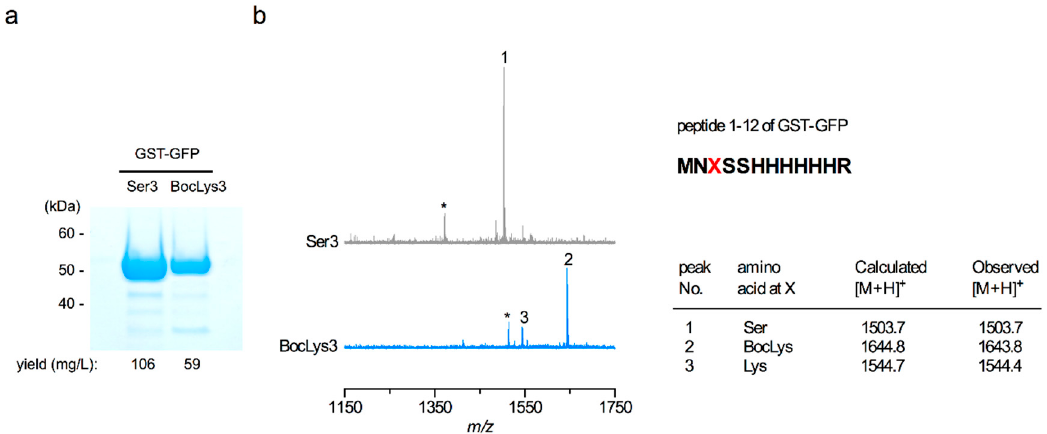
Figure 2. Analyses of the GST-GFP proteins with serine or amber codon at position 3. ( a ) These products were analyzed by SDS-polyacrylamide electrophoresis with Coomassie Brilliant Blue staining. ( b ) MALDI-ToF MS analyses of the trypsin-digested peptides of these products. The calculated and observed masses are tabulated in the table. The vertical axis indicates the signal intensity.